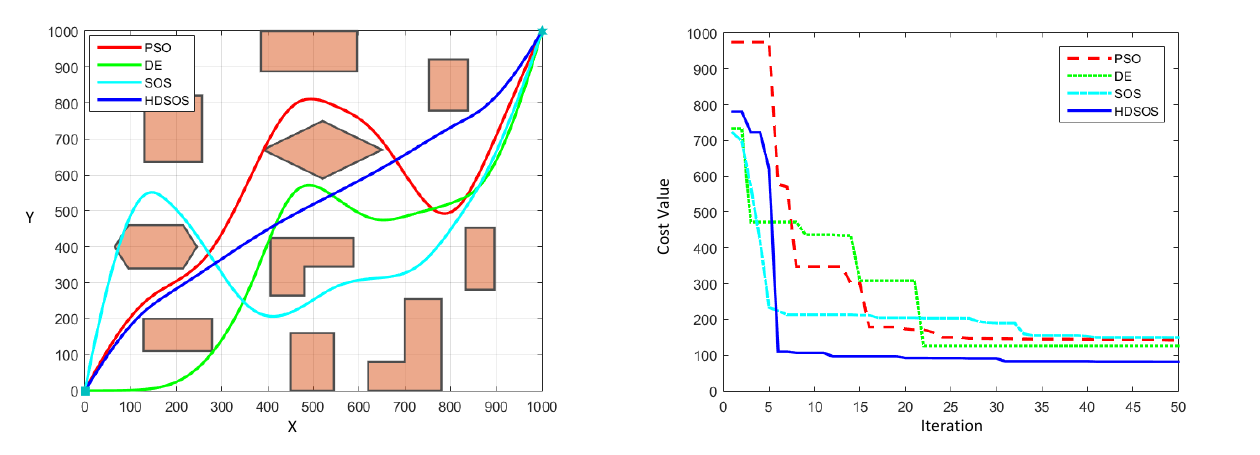
Figure 5. The comparative results for two-dimensional scenario A.